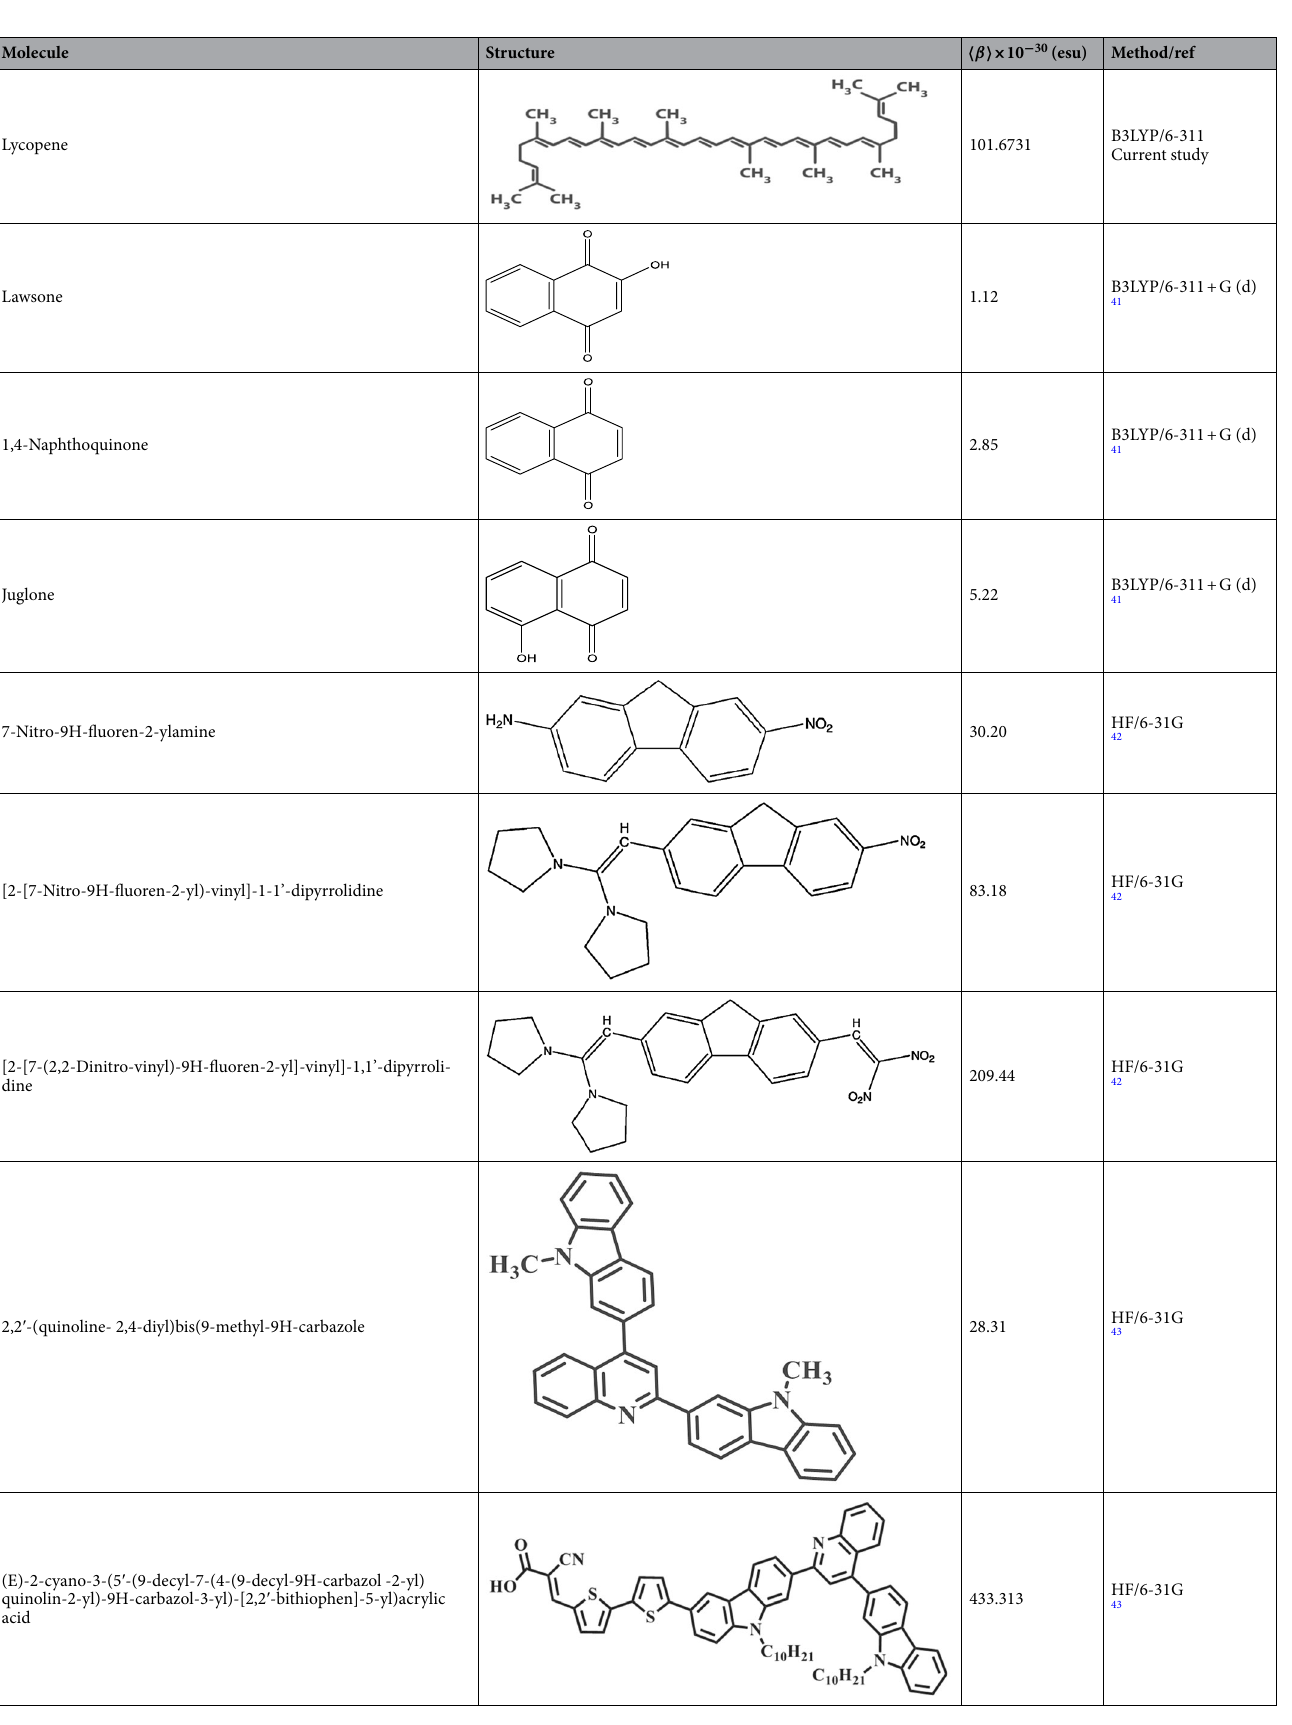
Table 7. Comparison of computed first order hyperpolarizability of lycopene with some other studied organic